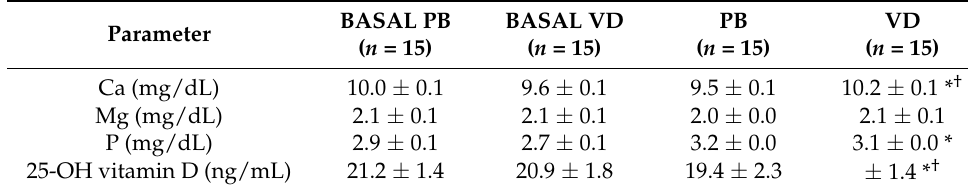
Table 4. Circulating minerals and 25-OH vitamin D levels.